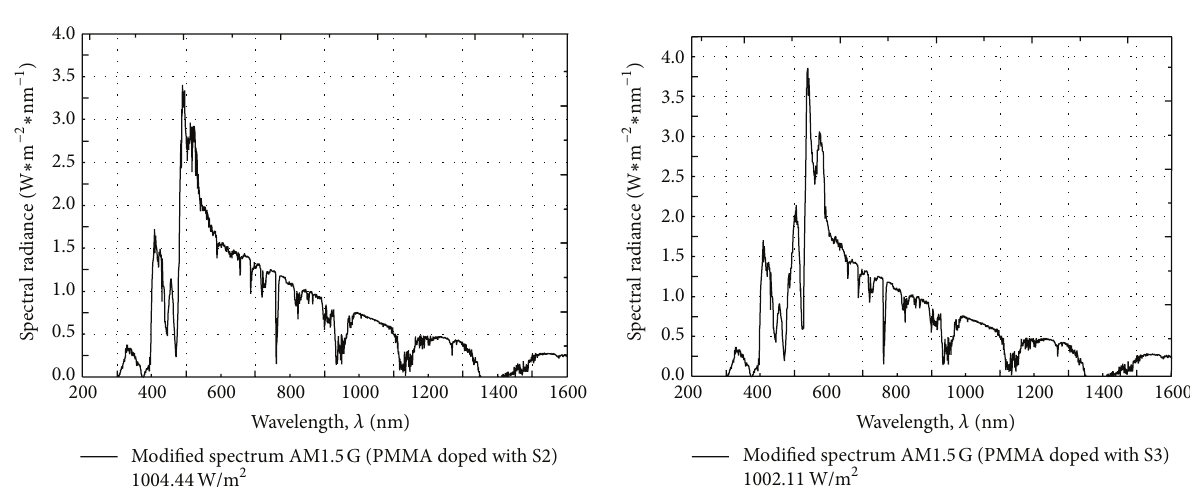
Figure 3: The luminescent downshift (LDS) effect on the AM1.5G solar spectrum.